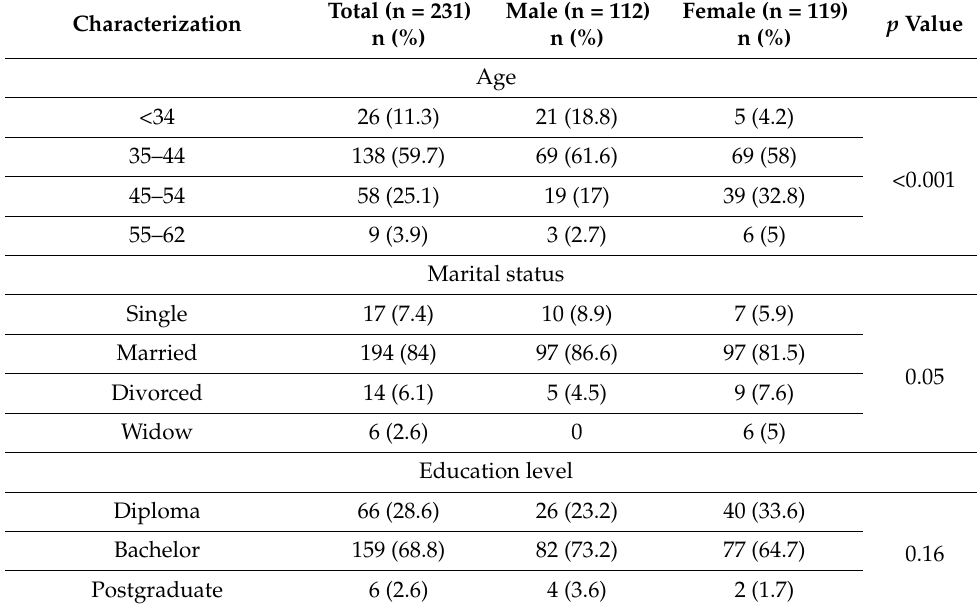
Table 1. Socio-demographic characteristics of health educators stratified by